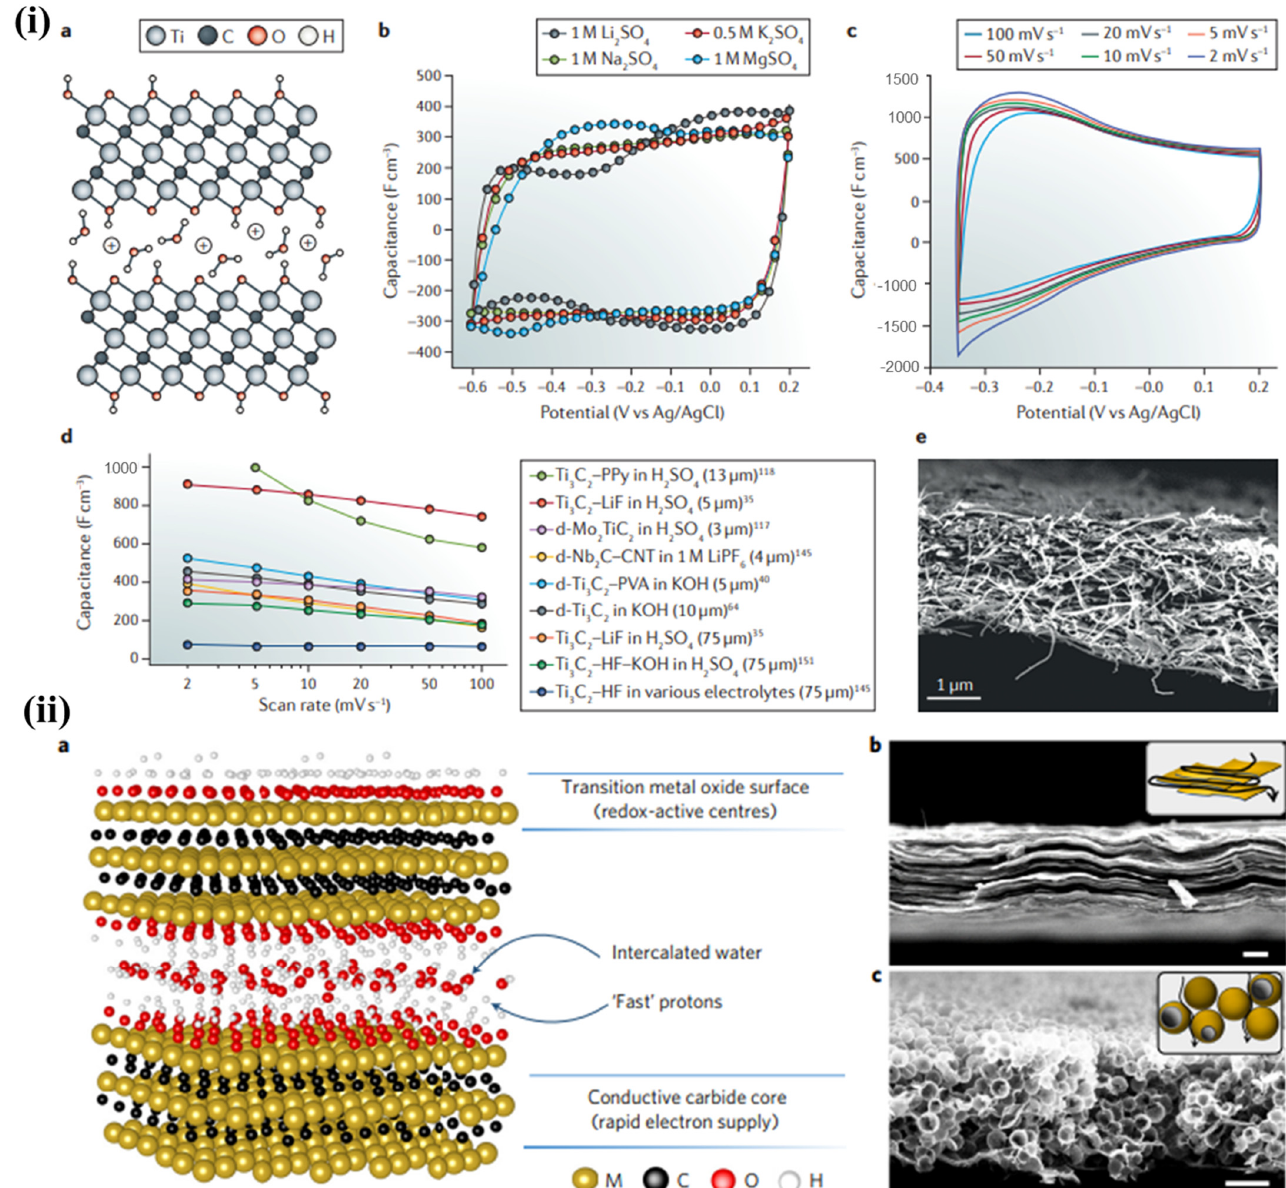
Figure 8. ( i ) An exemplification of MXenes. ( b , c ) Cyclic voltammograms of Ti 3 C 2 T x paper electrode. ( d ) Comparison study of MXene electrodes. ( e ) Cross-sectional image [67]. ( ii ) An exemplification and SEM images of Ti 3 C 2 T x MXene [74].